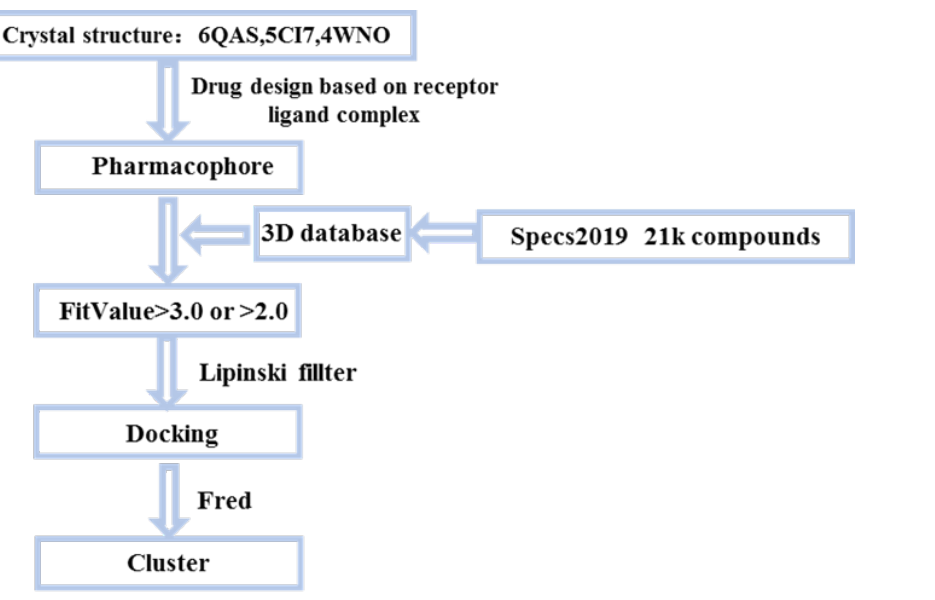
Figure 2. Small molecules screening process. Table 2. Scoring of selected compounds.